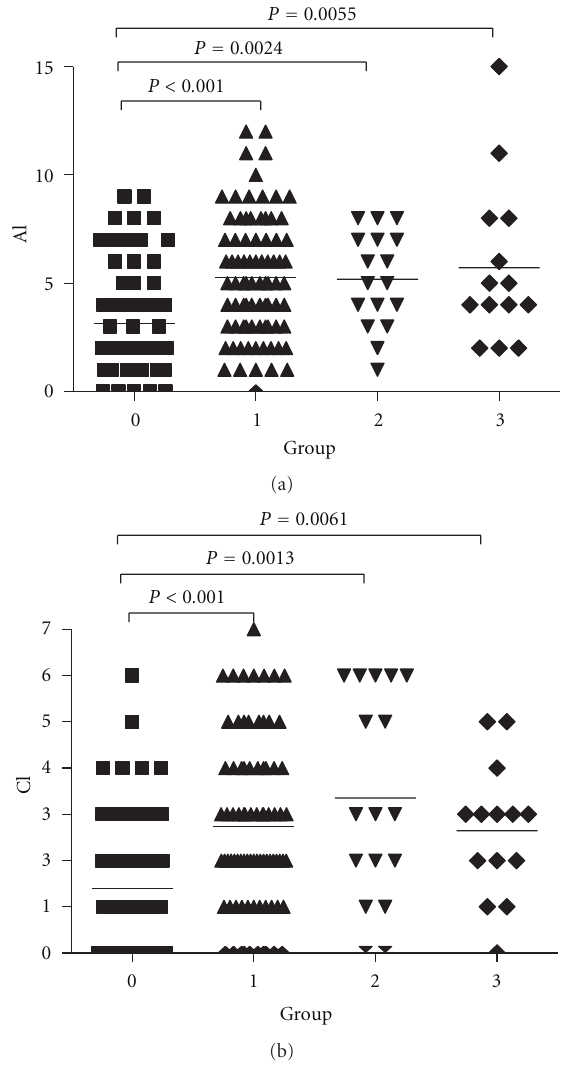
Figure 3: Lupus nephritis activity index (AI) and chronicity index (CI) in the four di ff erent B-cell groups of LN